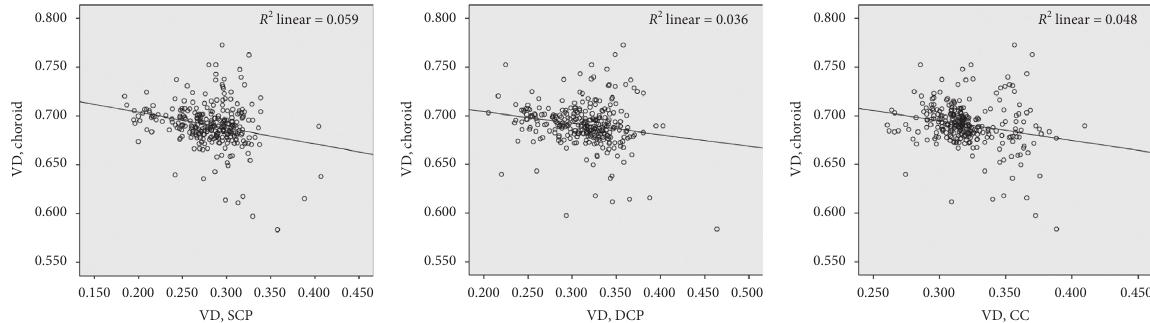
Figure 3: Correlation between choroidal vascular densities (VDs) and VDs of other layers. Choroidal vascular density (VD) showed weak negative correlations with VDs of other layers ( r � − 0.243, − 0.189, and − 0.220; P < 0 . 001, � 0.001, and < 0.001, for superficial capillary complex (SVC), deep capillary complex (DVC), and choriocapillaris, respectively). Table 2: Correlation between vessel densities and clinical